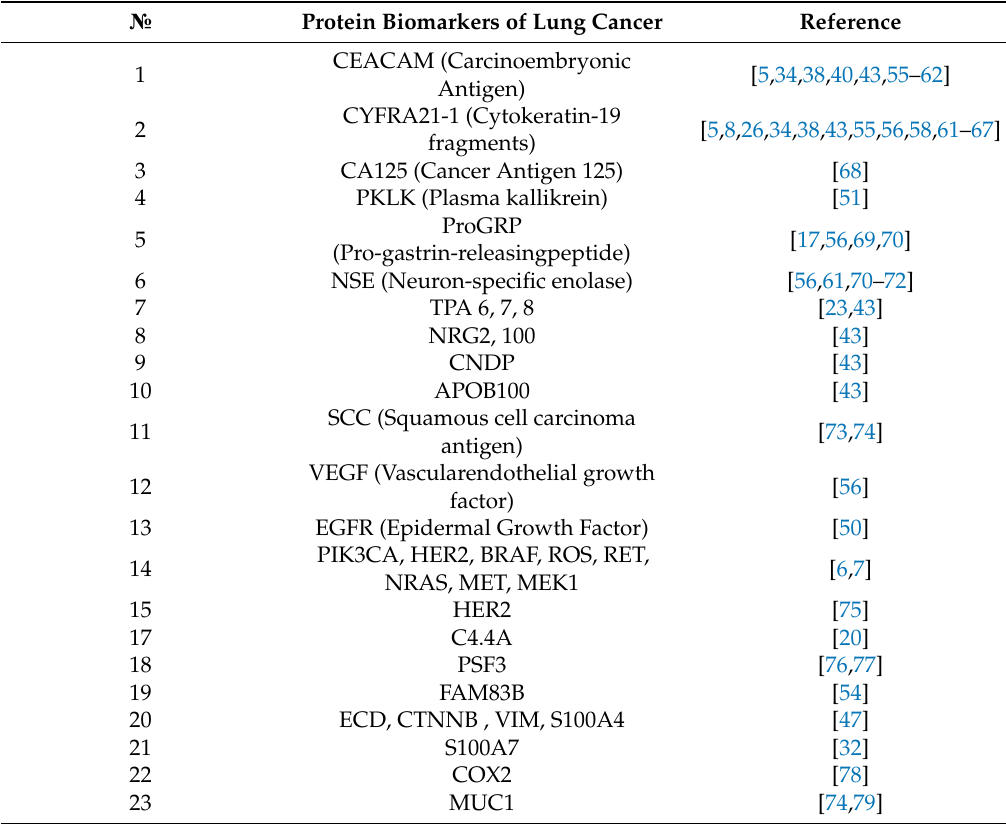
Table 2. Conventional protein biomarkers of lung